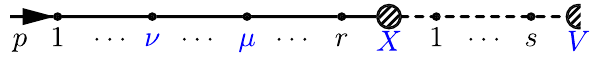
Fig. 15 Typical diagrams contributing to insertions of vertices μ and ν on the initial fermion (solid) line. The p (cid:6) leg remains unaffected by the insertions and hence is not shown, while the dashed line between vertices X and V denote the